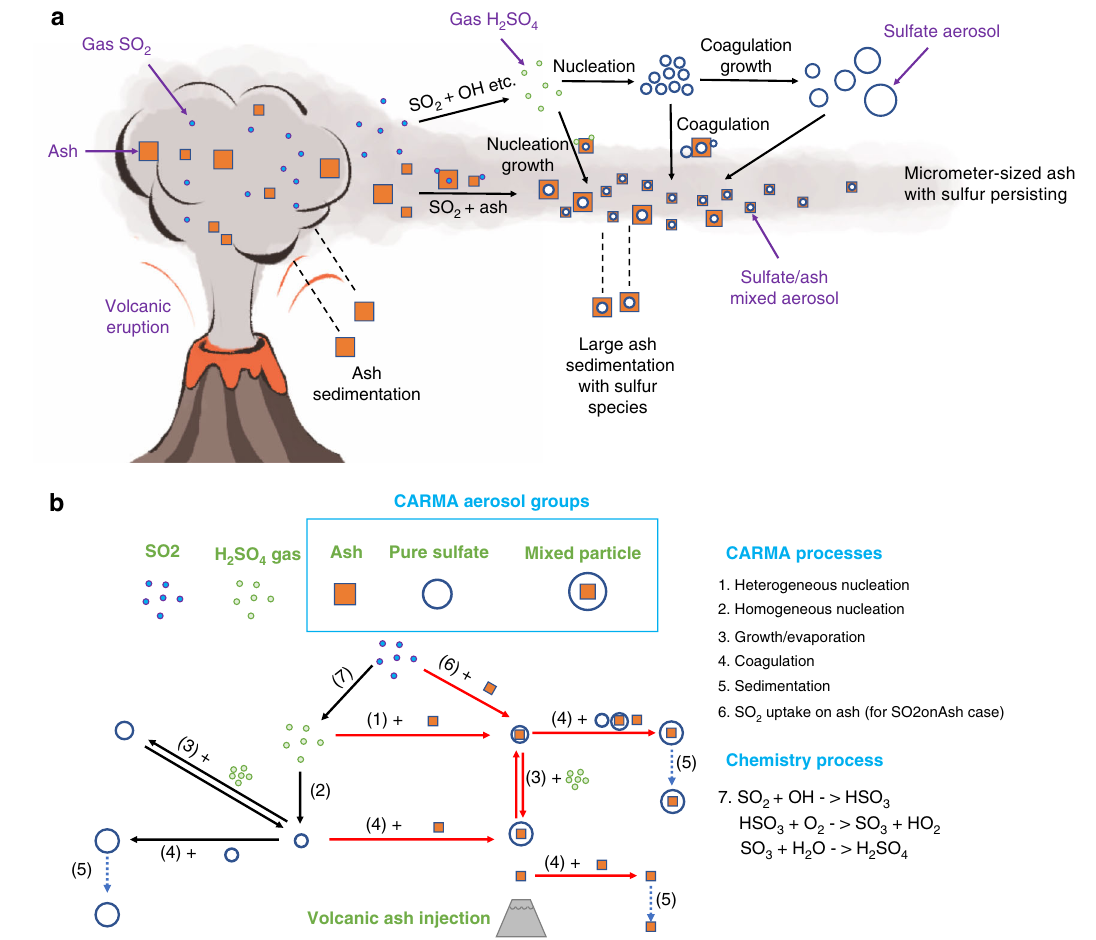
Fig. 1 A schematic diagram and the volcanic ash/sulfate module in the model. a A schematic diagram of the chemistry and microphysical processes for this work; b The three aerosol groups and the main microphysical processes involved in the volcanic ash/sulfate module in the CARMA model. The red arrows indicate the processes added to the model for this study relative to English et al. 42